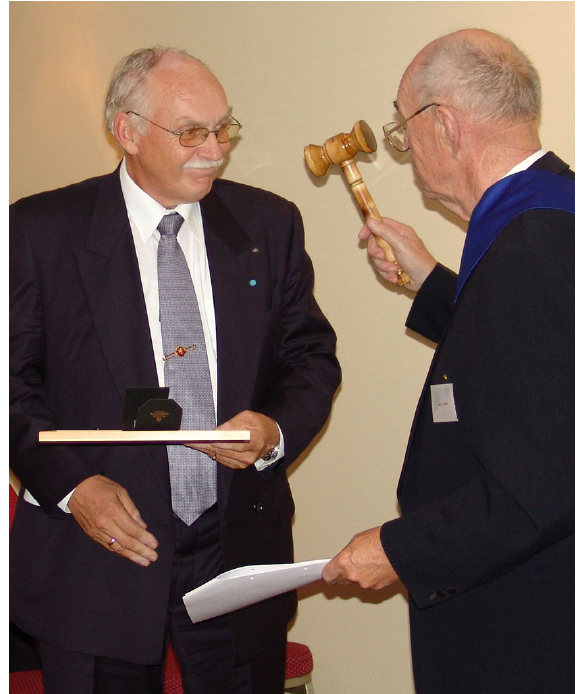
Figure 14: In 2004, Jens awards a mastership in the Order of the Golden Feedback Loop to Rolf Sk˚ar, then managing director of the Nor- wegian Space Centre (Norsk